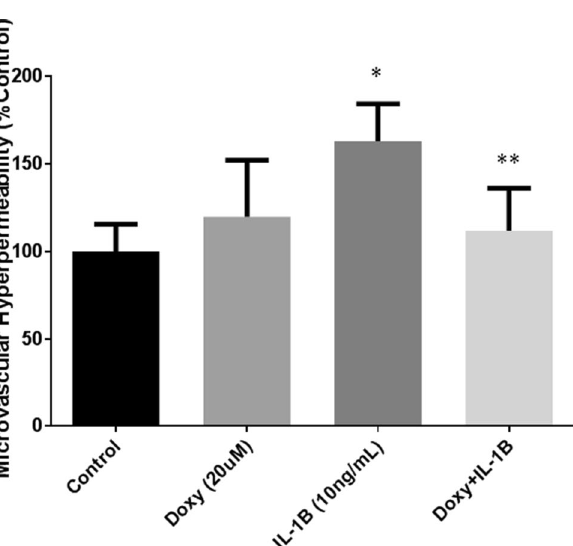
Figure 2. Evaluation of tight junction integrity by immunofluorescence of ZO-1 in the tight junctions. Rat brain microvascular endothelial cells were exposed to IL-1β and/or pre-treated with doxycycline. ( a ) Localization of ZO-1 at areas of cell-cell contacts/tight junctions. Arrows indicate areas of tight junction disruption. ( b ) Quantification of ZO-1 immunofluorescence. There was significant decrease in the ZO-1 localization in the cells treated with IL-1β (n = 4). This was prevented with treatment of doxycycline (n = 4). The analysis was performed with ImageJ. Compared to control * p < 0.05. Compared to IL-1β ** p < 0.05.